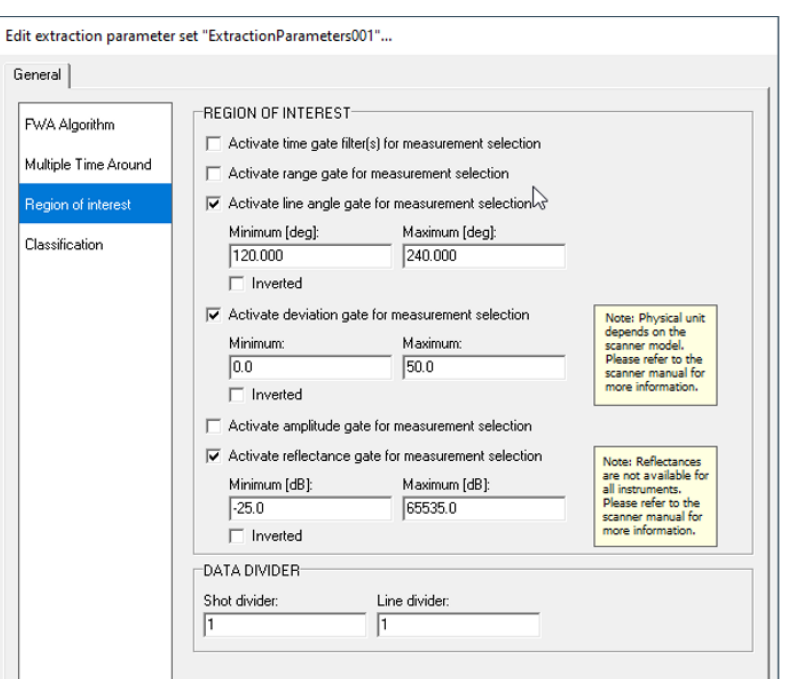
Figure 2. Extraction parameters for LiDAR data